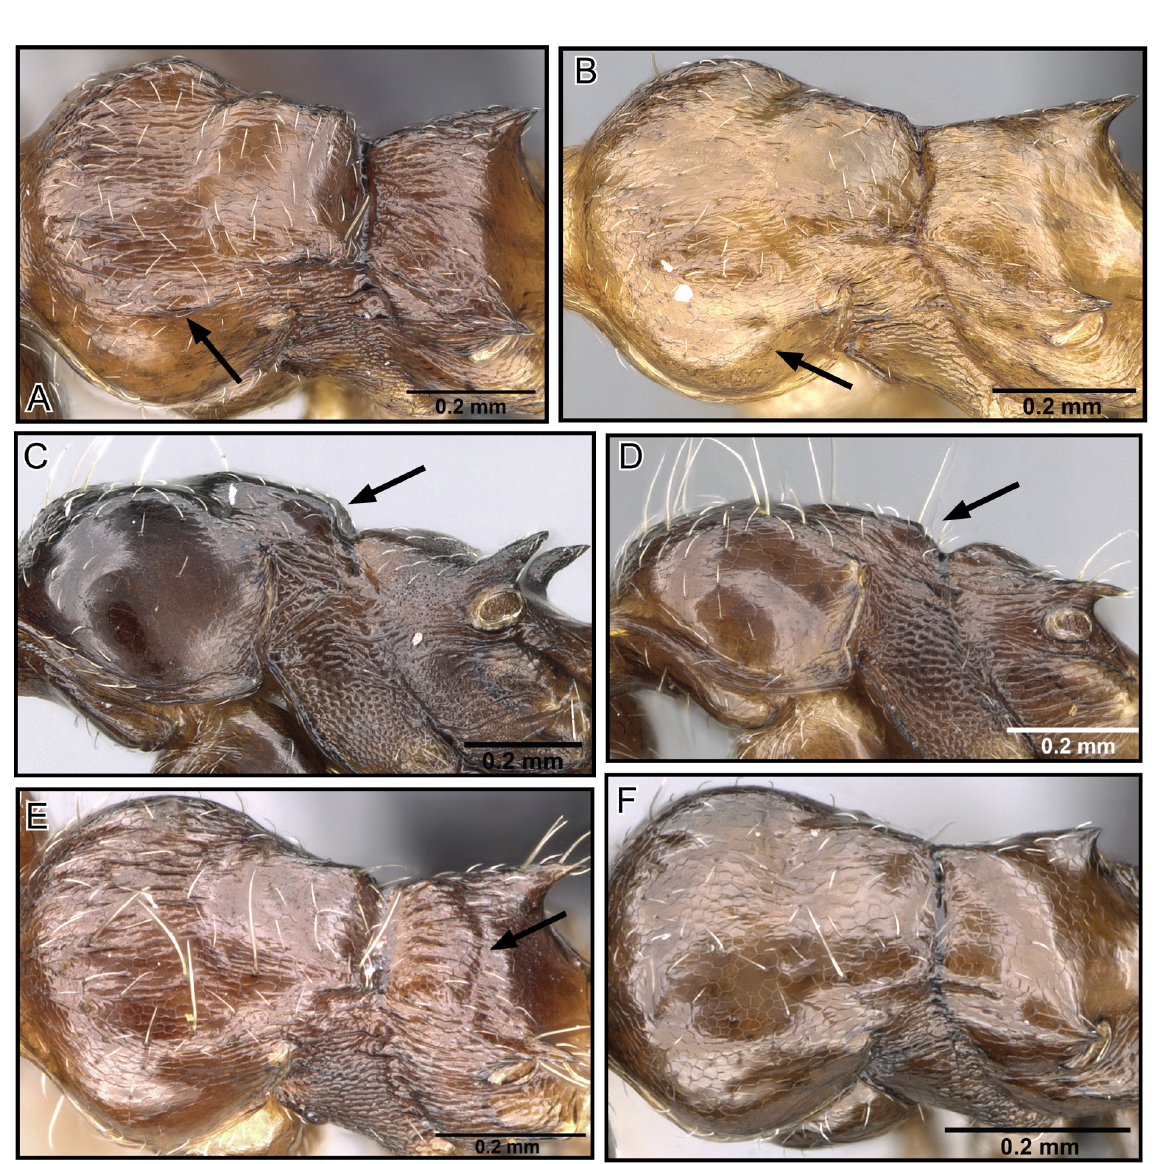
Fig. 5. Key to the species of the C. degeeri -assemblage (part II). A. Pronotum with sharp lateral